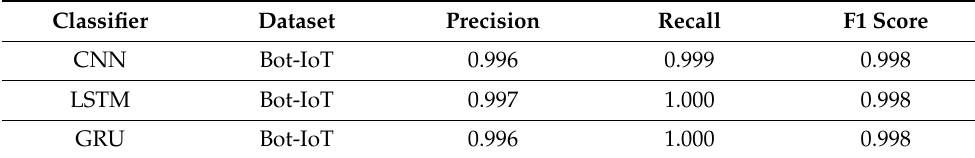
Table 5. Result experiment for precision, recall, and F1 score.